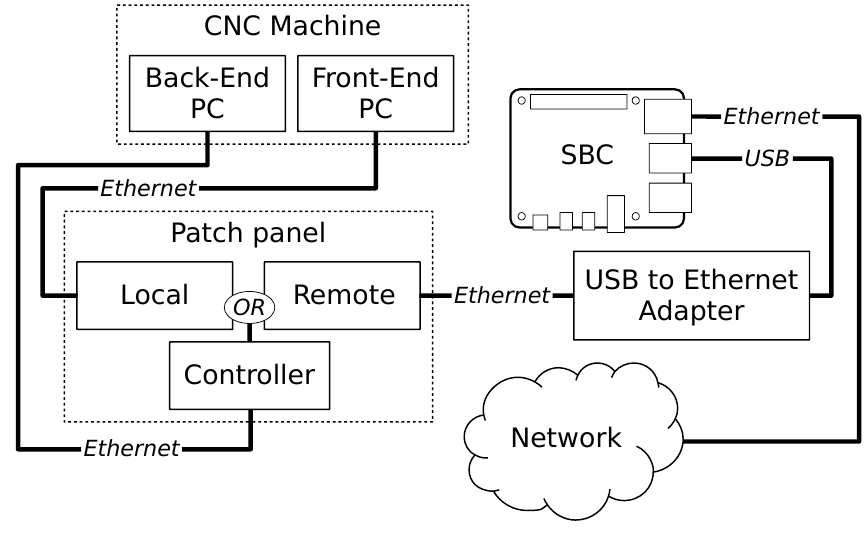
Figure 5. Principle NAT server